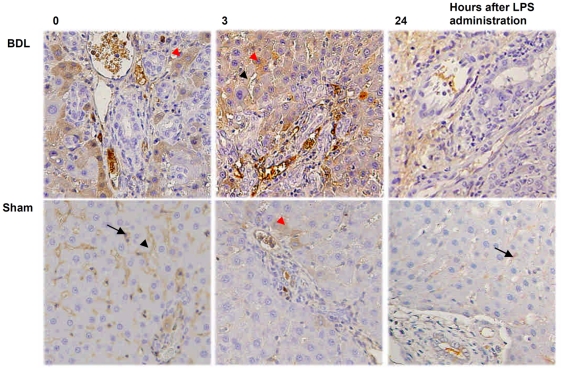
CD14 expression rat liver tissue after LPS administration.Comparison of CD14 expression in paraffin-embedded liver tissue sections among BDL and sham-operated rats after 0.5 mg/kg administration for 3 h and 24 h. Liver sections were stained with a polyclonal antibody against CD14 (dark brown) and counterstained with hematoxylin. CD14 immunoreactivity was detected in Kupffer cells (black arrow), sinusoidal endothelial cells (black arrowhead), and hepatocytes (red arrowhead). Original magnification: ×200.